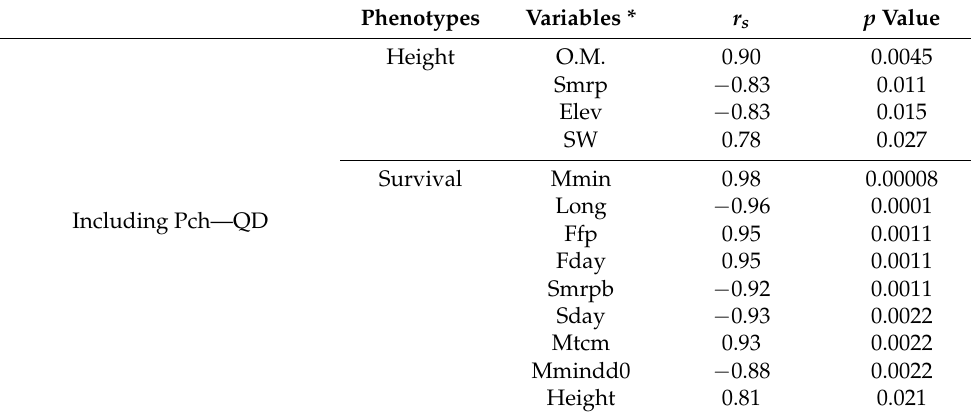
Table 6. Spearman correlation ( r s ) between mean seedling height (H, mm), survival (%) (SU) and weight of 1000 seeds (SW, g) with climatic and soil variables (var) ( α = 0.025) (* There was strong collinearity of seedlings height, survival and seed weight with respect to some climate variables and also with the percentage of silt (%Silt), organic matter and potassium in the soil ( r s > 0.9); O.M. = organic matter (%), Smrp = summer precipitation, Elev = elevation (m), Mmin = mean minimum temperature of the coldest month ( ◦ C), Long = longitude (m), Ffp = length of the frost-free period (days), Fday = Julian date of the first autumn freezing (days), Smrpb = summer precipitation balance (ratio), Sday = Julian date of the last spring freezing (days), Mtcm = mean temperature of the coldest month ( ◦ C), Mat = mean annual temperature ( ◦ C), Mtwm mean temperature of the warmest month ( ◦ C) and degree-days above 5 ◦